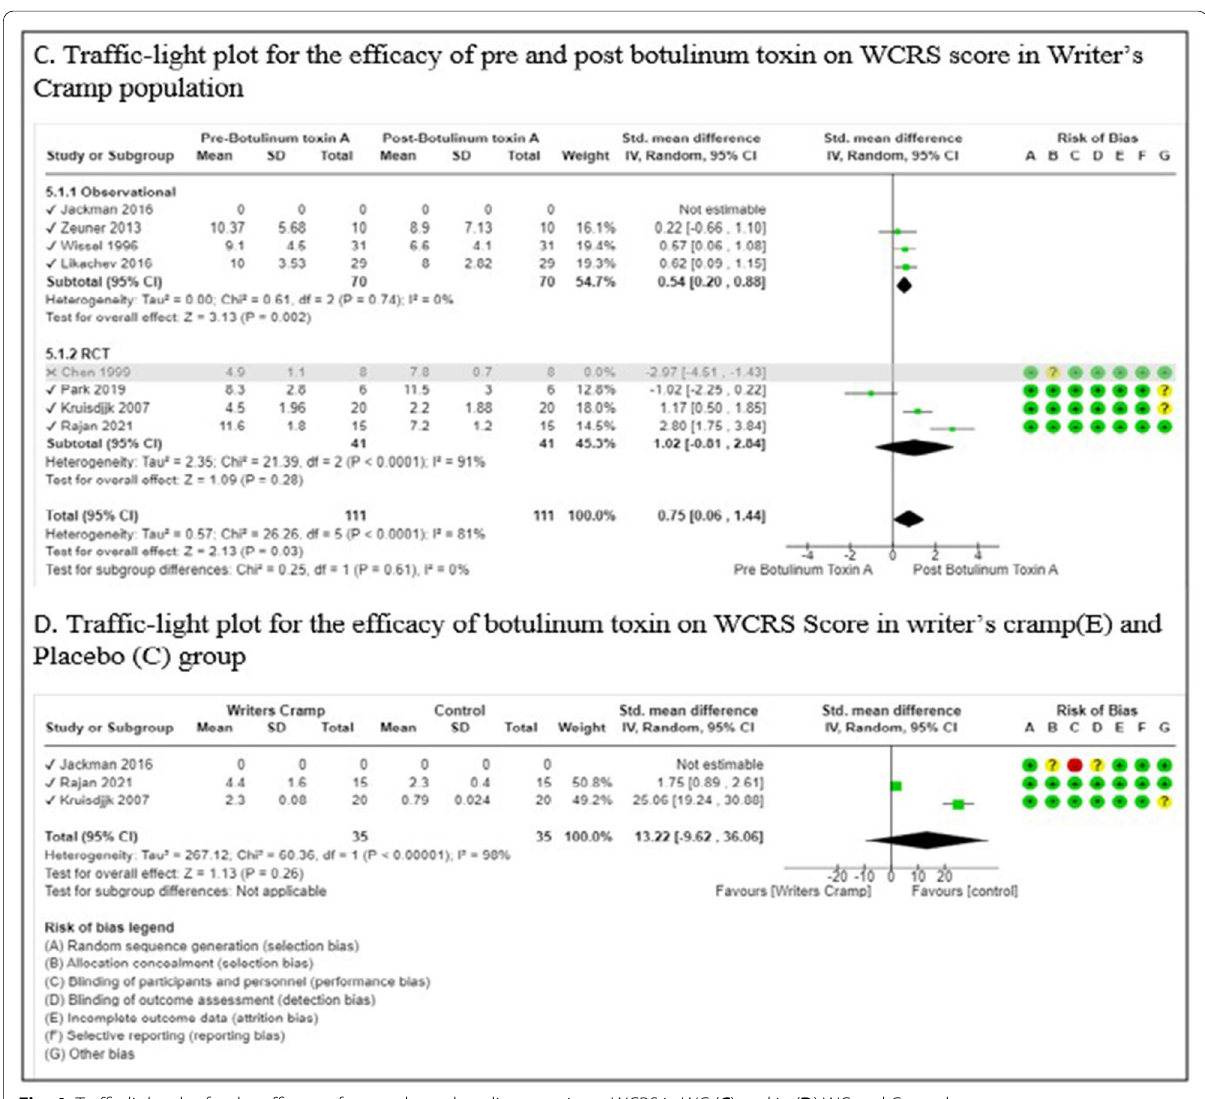
Fig. 4 Traffic light plot for the efficacy of pre and post botulinum toxin on WCRS in WC ( C ) and in ( D ) WC and